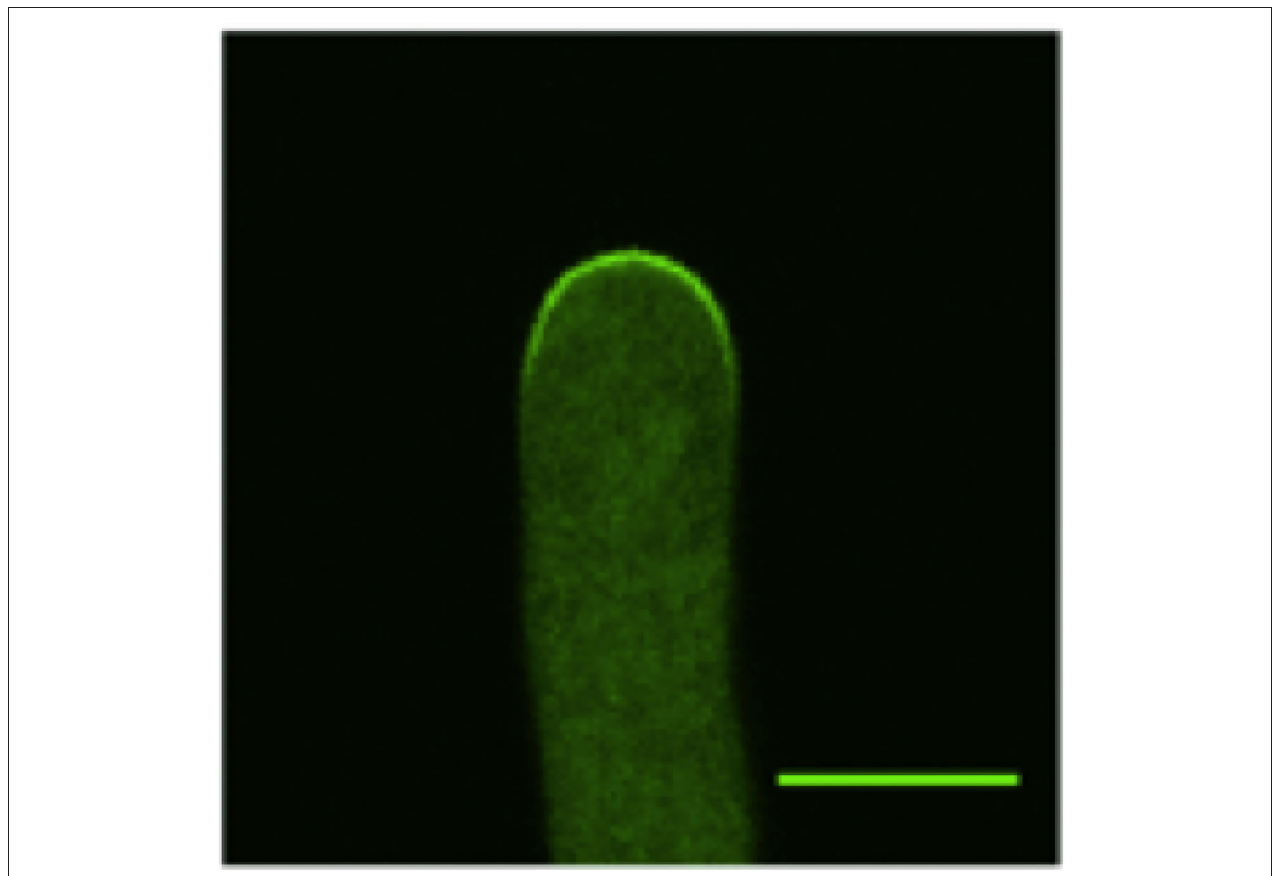
FIGURE 1 | Confocal microscopy image of a wild-type Arabidopsis pollen tube expressing CRIB4-GFP that shows the distribution of the active ROP1. Only the tip region of the pollen tube is shown (The bar is 7 µ